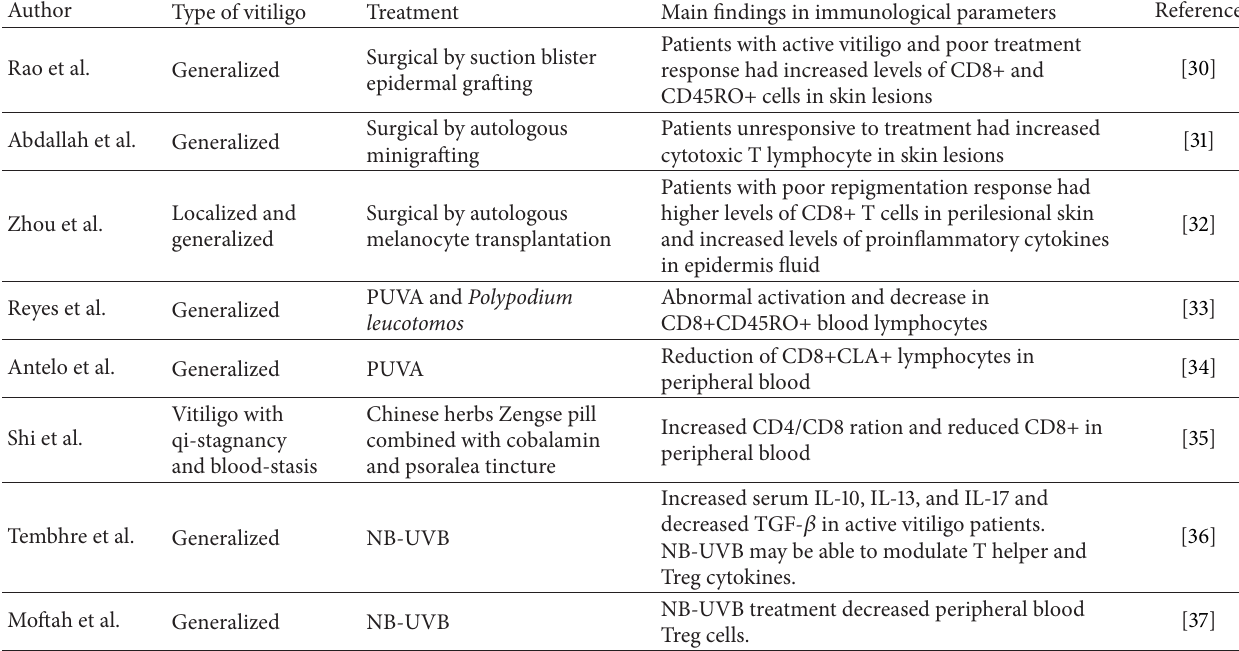
Table 1: Summary of immunological parameters associated with vitiligo treatments reported in the